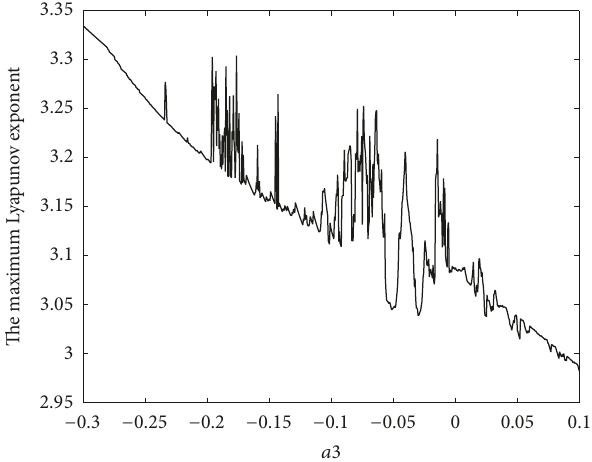
Figure 4: The maximum Lyapunov exponent